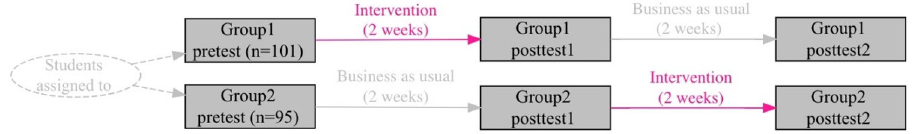
Fig 1. General overview of switching replications design. Group 2 thus serves as a control to group 1. When the control group later receives the treatment, the original treatment group then serves as a continued-treatment control